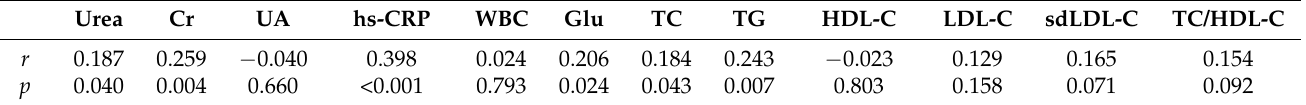
Table 4. Spearman correlation coefficients between circulating GDF-15 and risk factors of depression in MDD patients.